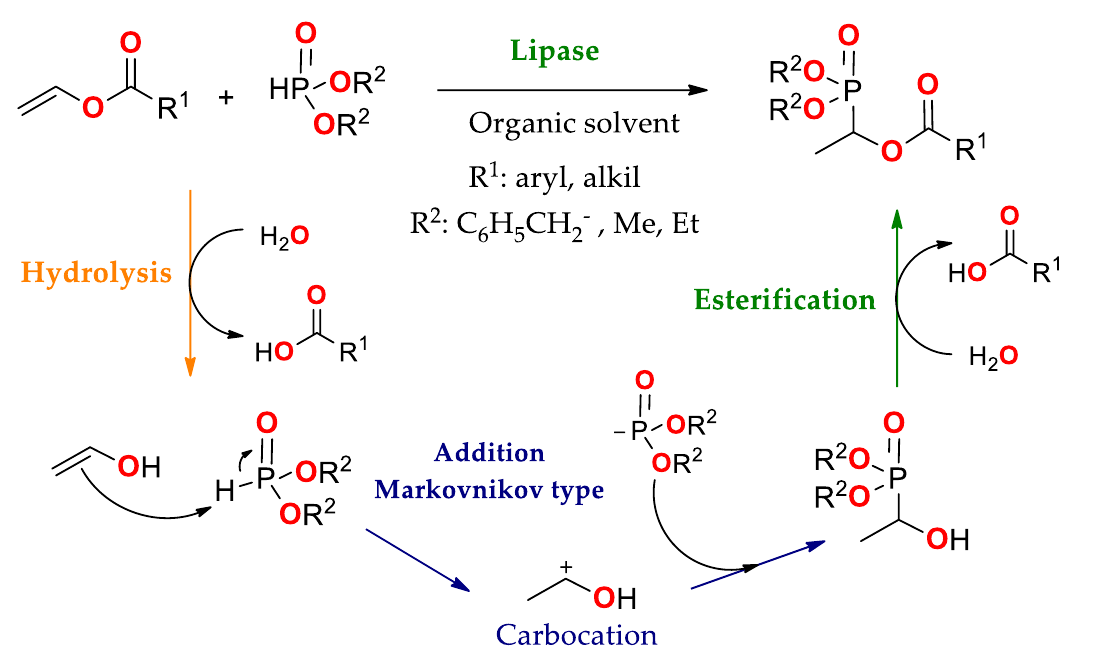
Scheme 19. Synthesis of α− Hydroxy phosphonate derivatives using lipases as reaction catalyst. Here, a mechanism involving three reaction stages is proposed, where only the Markovnikov − type addition of the allyl alcohol double bond. Adapted from